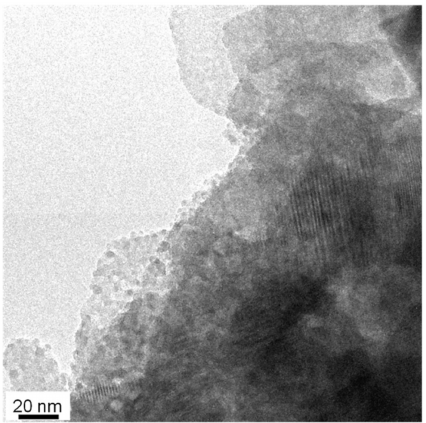
Figure 3. TEM image at medium magnification of sample 1.